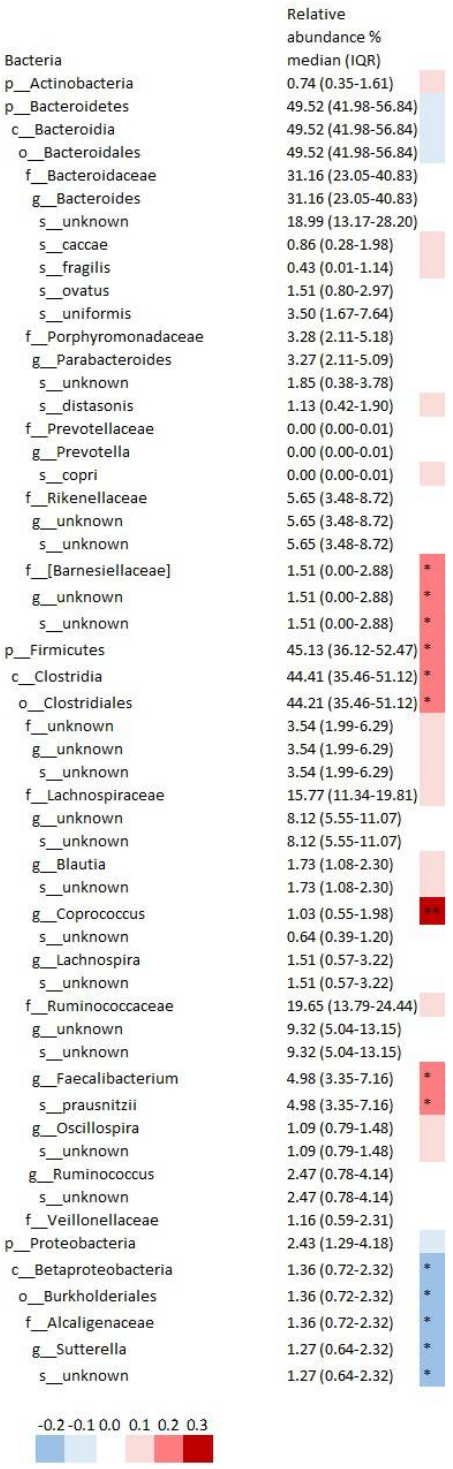
Figure 2. Correlations between IDQ scores and the relative abundance of bacteria. * FDR < 0.2, ** FDR < 0.1. The p -values for the correlation were corrected for multiple testing. The false discovery rate (FDR) was 0.2 *, but also those with FDR < 0.1 are shown **. The colors represent the Spearman’s rho (blue: negative correlation, red: positive correlation).